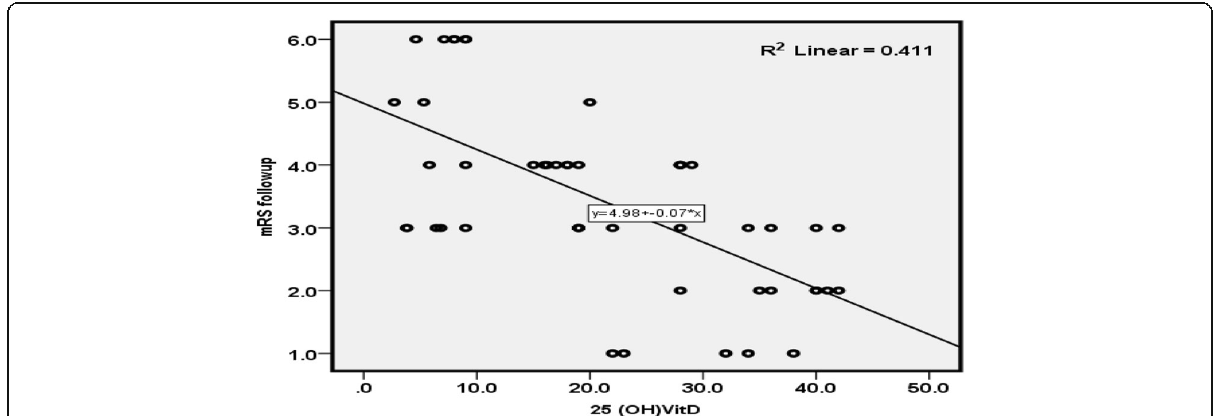
Fig. 1 Correlation between serum vitamin D level and mRS (modified Rankin Scale) score after 3 months